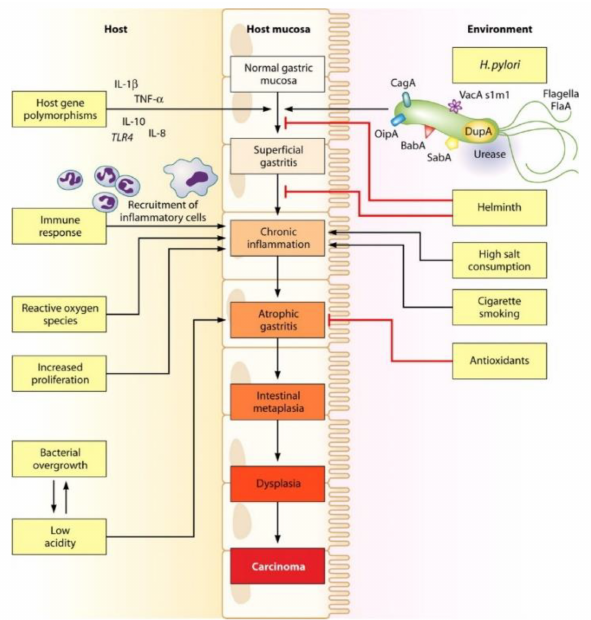
Figure 3. Physio-pathological events associated with an H. pylori infection. Reprinted with permission from Ref. [15]. Copyright 2010 American Society for Microbiology